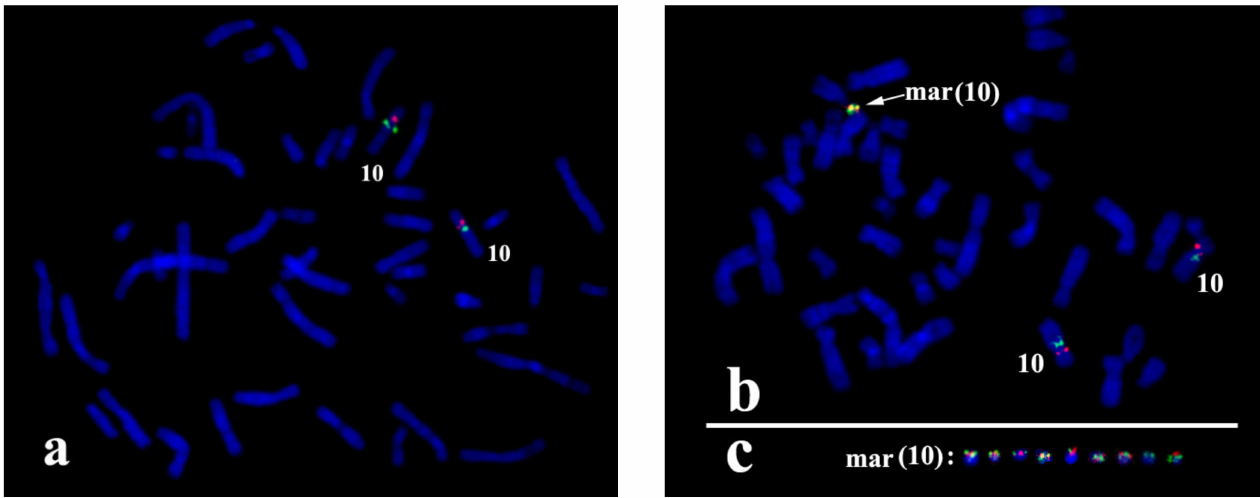
Figure 6. FISH with locus-specific probes ZNF248 (10p11.21) (red signals) and MAPK8 (10q11.22) (green signals) ( a ) on metaphase chromosomes of healthy donors; and ( b ) foetuses; ( c ) a gallery of sSMCs from different metaphase spreads with FISH